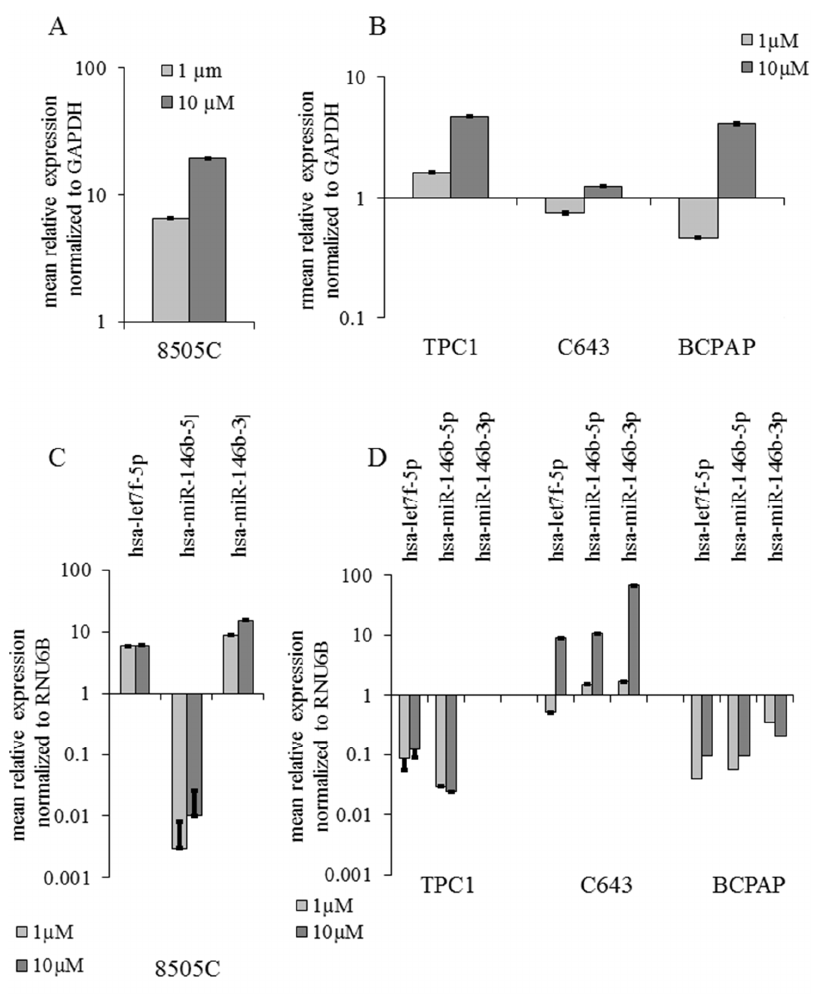
Figure 6. Summary of selumetinib mediated effects on NIS (SLC5A5) and miRNA expression. RT-qPCR of SLC5A5, hsa-let7f-5p, hsa-miR-146b-5p and hsa-miR-146b-3p transcripts in 8505C cells ( A , C ) treated with selumetinib for 1 h and TPC1 C643 and BCPAP cells ( B , D ) treated for 48 h. SLC5A5 was normalized to GAPDH (Glyceraldehyde 3-Phosphate dehydrogenase). MiRNAs were normalized to RNU6B. Results are expressed relative to the untreated control. Data represent mean ± SEM of experiments performed in